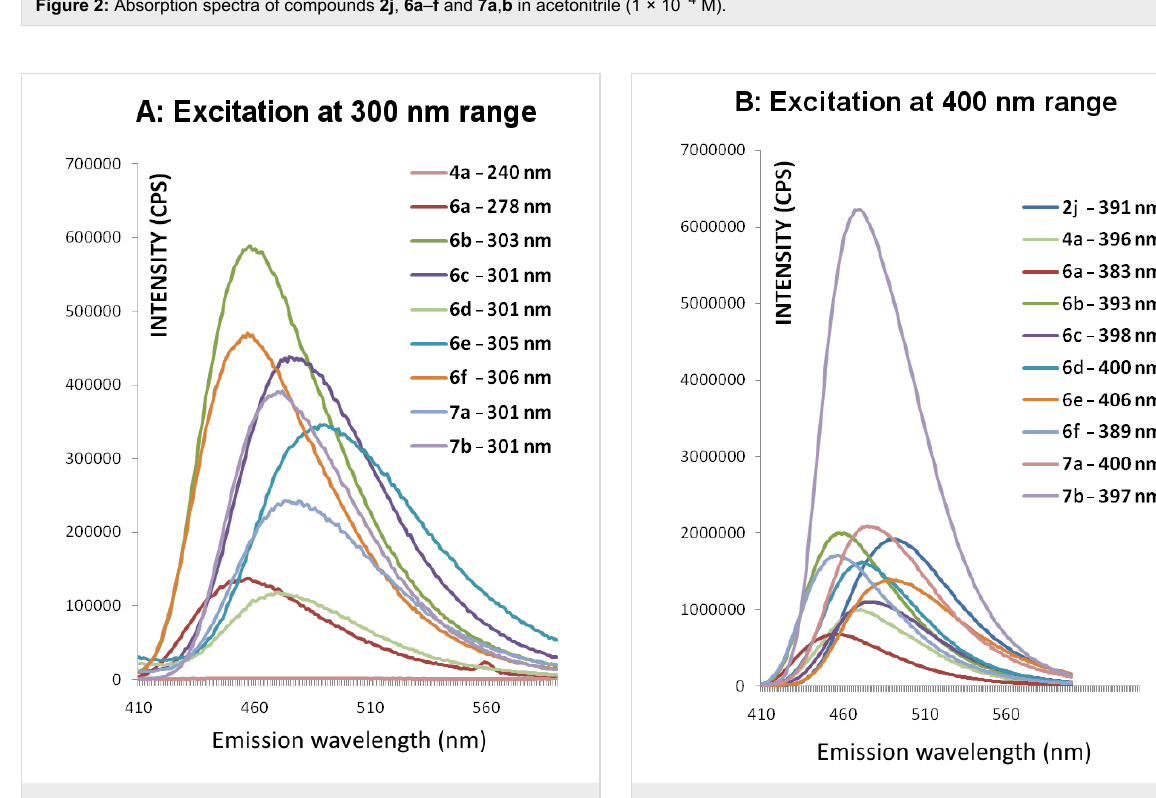
Figure 3: Emission spectra of compounds 4a , 6a – f and 7a , b after excitation at their absorption λ max in the range of 240–306 nm in aceto- nitrile (1 × 10 − 4 M).